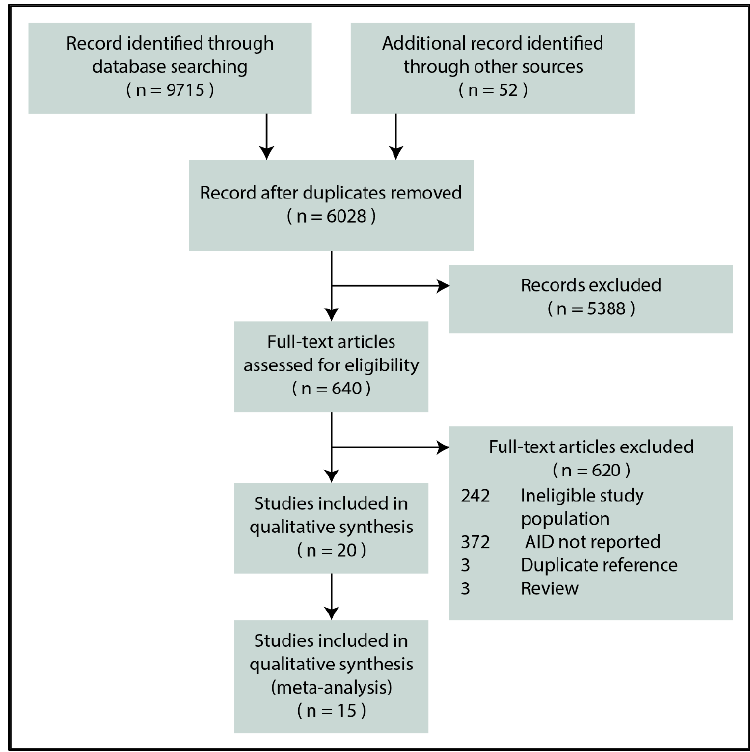
Figure 1. PRISMA flowchart (AID: autoimmune disease). Table 1. CeD prevalence from consecutive studies (SD: standard deviation, CF: cystic fibrosis, CeD: celiac